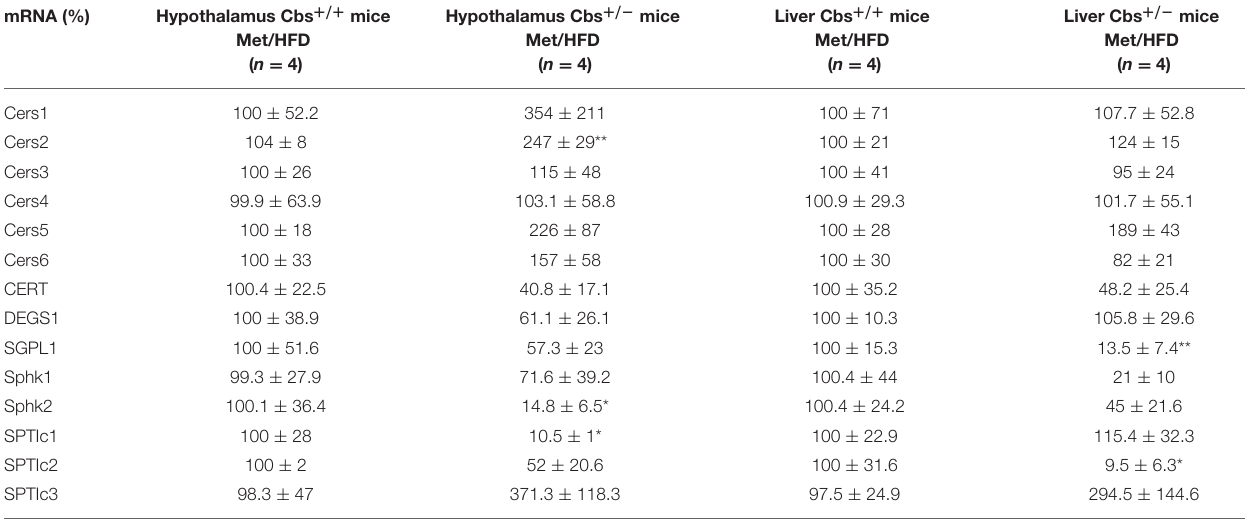
TABLE 1 | Relative liver and hypothalamus mRNA expression based upon Q-PCR data obtained from wild-type (Cbs + / + mice) and mice heterozygous for targeted disruption of the Cbs (Cbs + / − mice) on a methionine enriched diet (Met) and high fat diet (HFD). mRNA (%)